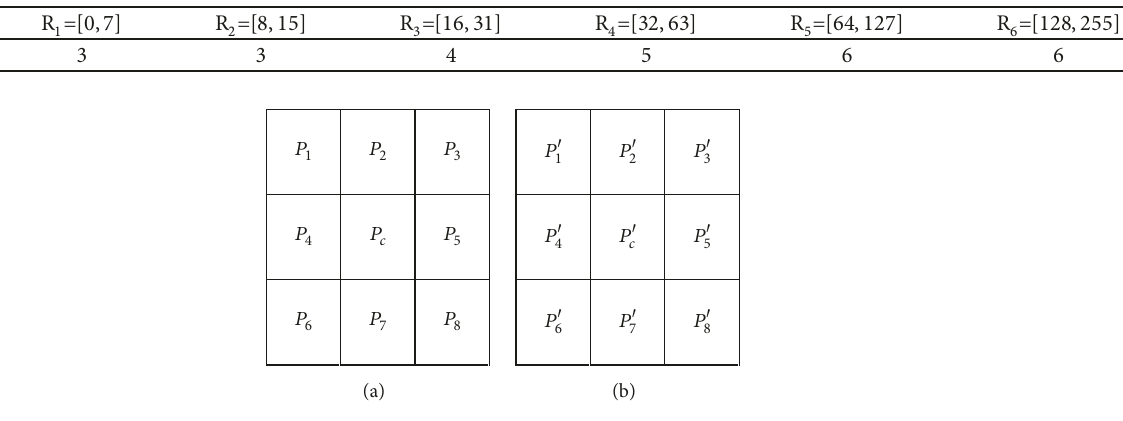
Figure 1: (a) Original block; (b) stego